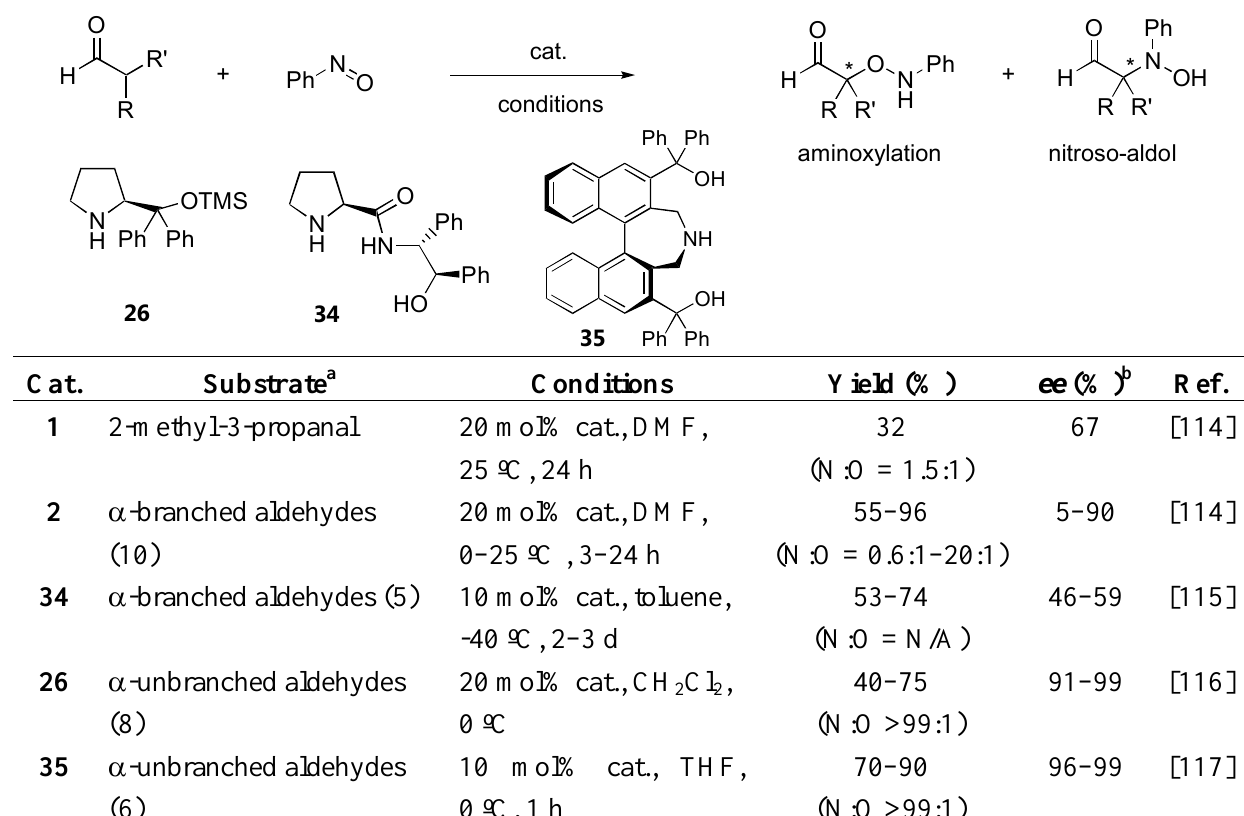
Table 8. Comparison of catalysts in aminoxylation/nitrosoaldol reactions of